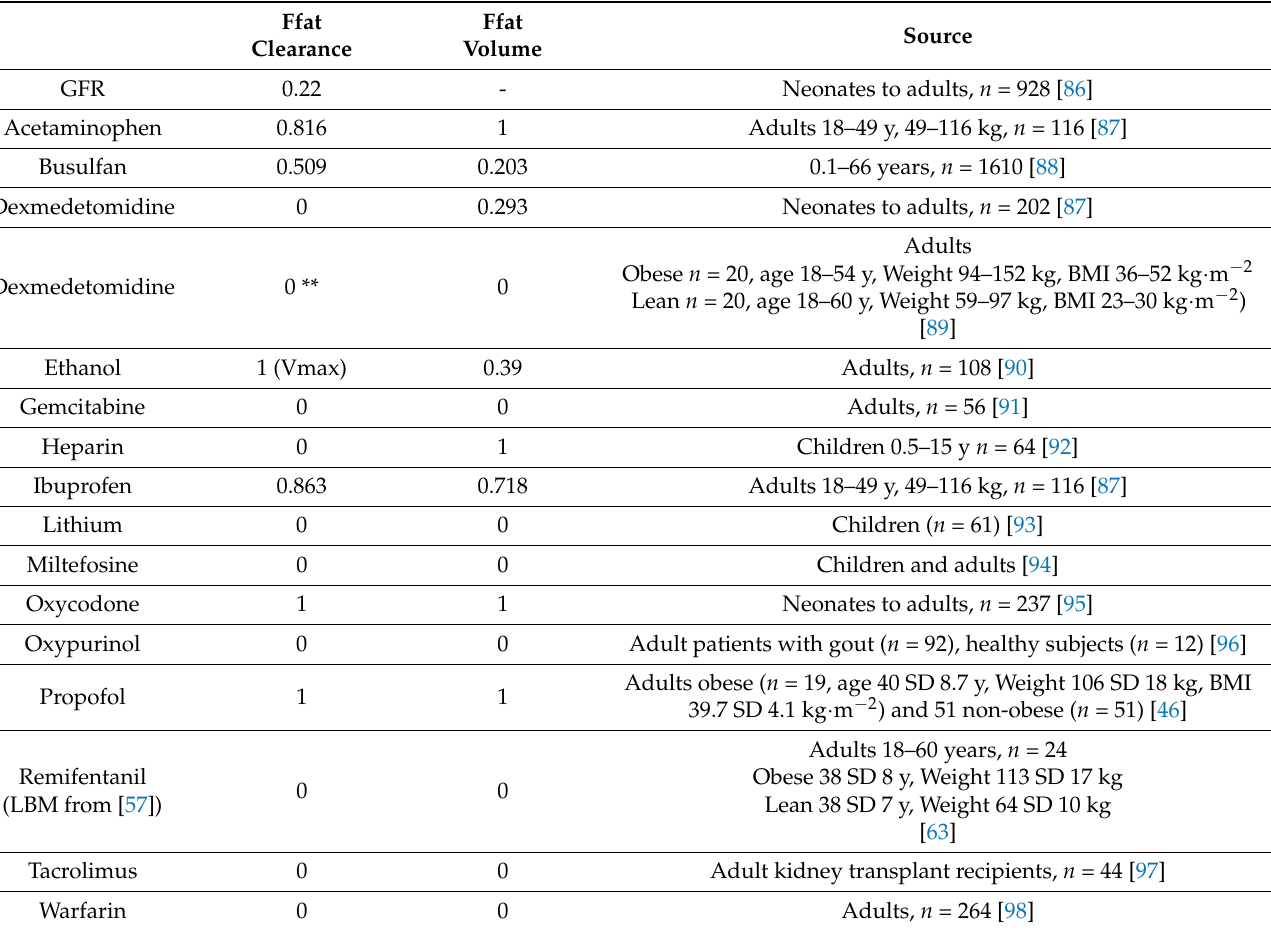
Table 1. Factor of fat (Ffat) estimates for pharmacokinetic parameters of clearance and volume of distribution for glomerular filtration rate (GFR) and selected drugs that have been investigated.